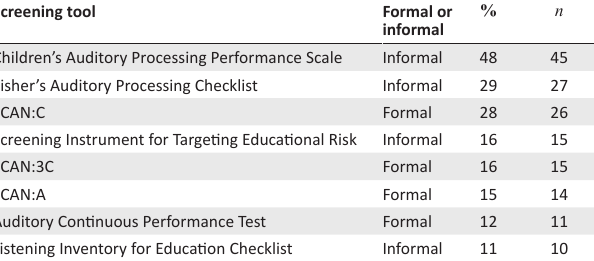
TABLE 2: Common screening tools administered by South African audiologists. Screening